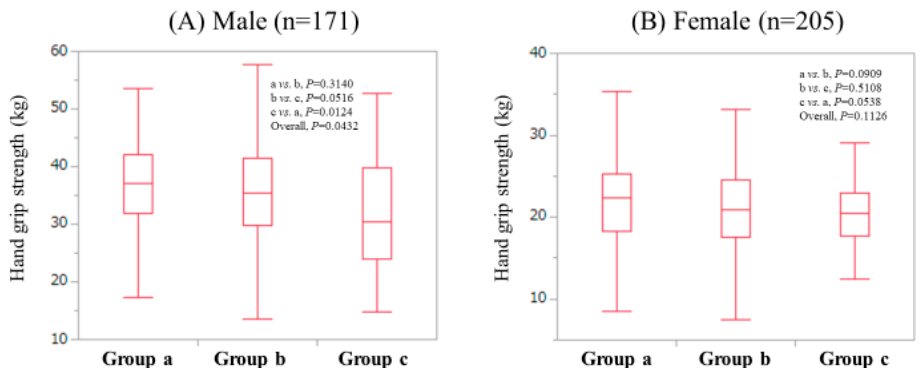
Figure 3. GS value according to BMI in males ( A ) and females ( B ); Group A indicates patients with BMI > 25 kg/m 2 ; Group B indicates patients with 20 kg/m 2 < BMI < 25 kg/m 2 ; Group C indicates patients with BMI < 20 kg/m 2 .